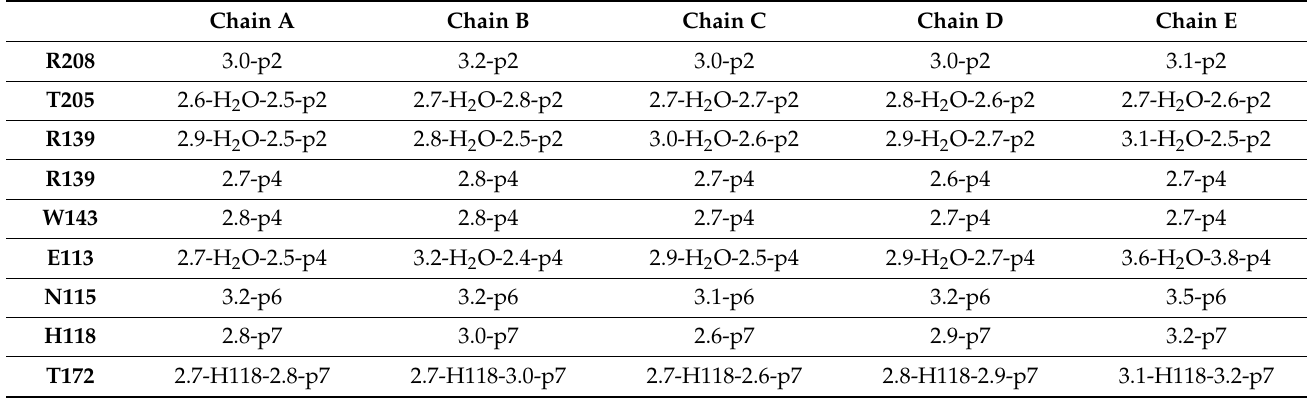
Figure 1. Structure of the active sites of coproheme complex of Cd ChdC WT (PDB ID: 6XUC), showing the hydrogen bonds (yellow dotted lines) between the polar residues and the propionate groups as observed in Chain A [13]. Red crosses indicate water molecules. Table 1. Hydrogen bond distances (in Å) between the polar residues and the coproheme propionate groups in the active site of the five chains of Cd ChdC, as evinced by the crystal structure (PDB ID: 6XUC)